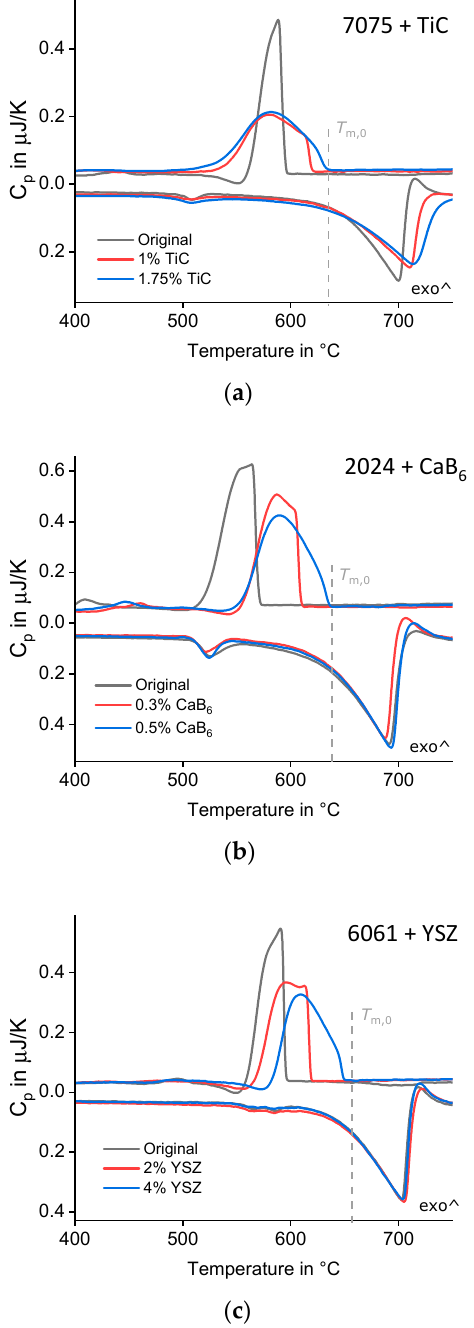
Figure 2. Exemplary DFSC heating and cooling curves ( a ) alloy 7075 without and with TiC nanopar- ticles, rate 10 4 K/s. ( b ) Alloy 2024 without and with CaB 6 nanoparticles, rate 10 4 K/s. ( c ) alloy 6061 without and with YSZ nanoparticles, rate 10 3 K/s. The vertical axis shows heat capacity in µ J/K, exothermal reactions